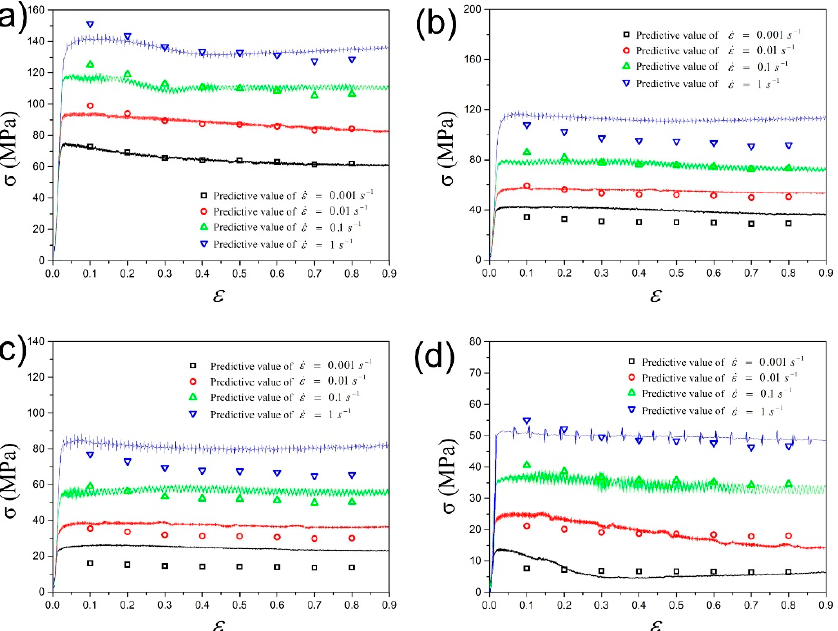
Figure 7. Comparison between the predictive value of the constitutive model fitted by a fourth- order polynomial and the experimental stress-strain curves at temperature of ( a ) 320 °C, ( b ) 380 °C, ( c ) 440 °C and ( d ) 500 °C, respectively.